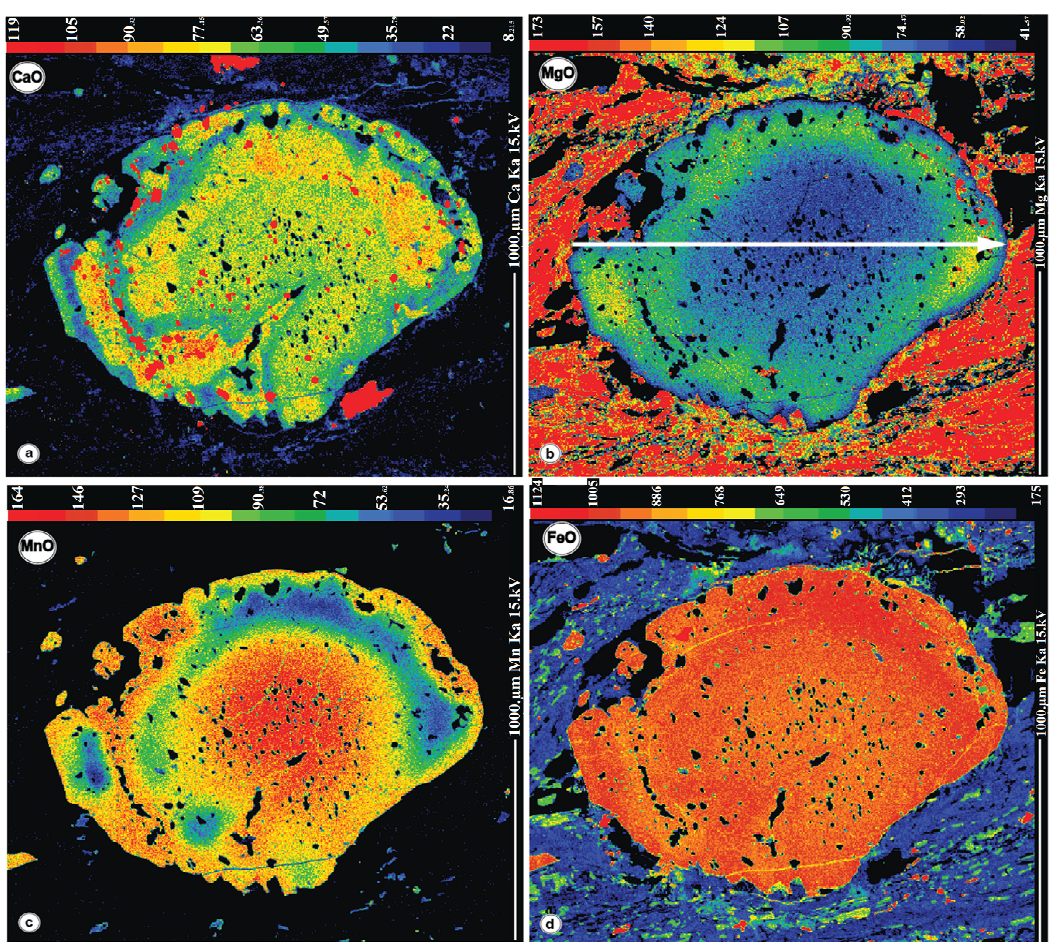
Figure 6. X-ray mapping of garnet from the migmatitic paragneisses of the Filali unit. ( a ) CaO, ( b ) MgO, ( c ) MnO, and ( d ) FeO mapping. Note that the “warm” colors indicate high concentrations and the “cold” colors indicate low concentrations. The white line in ( b ) refers to the location of the garnet compositional profile shown in Figure 7.